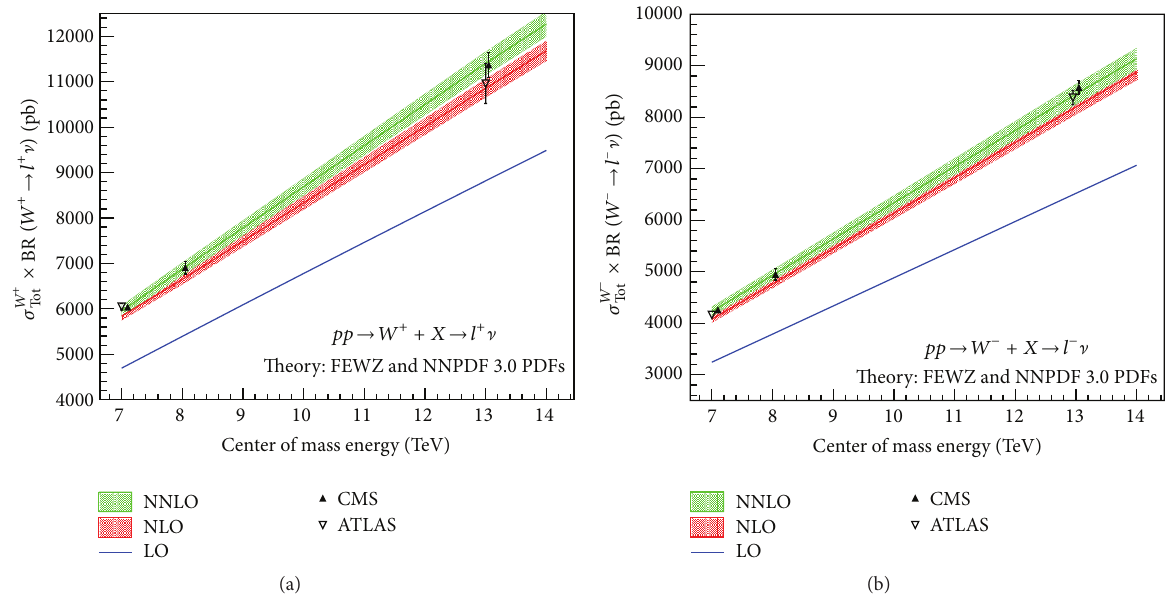
Figure 2: Experimental results of total 𝑊 production cross section are compared with theoretical predictions. 13TeV CMS and ATLAS collaboration results are preliminary.